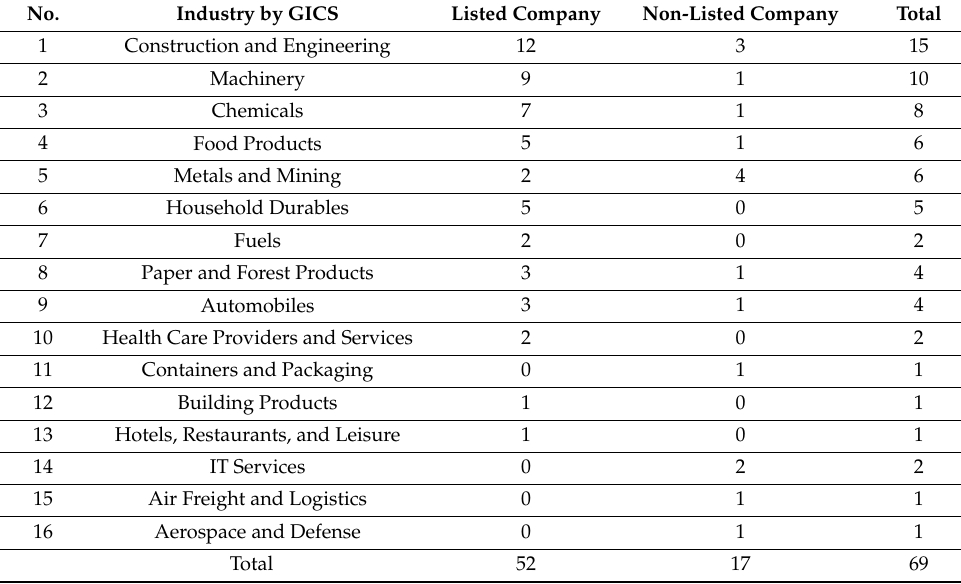
Table 2. Characteristics of identified corporate